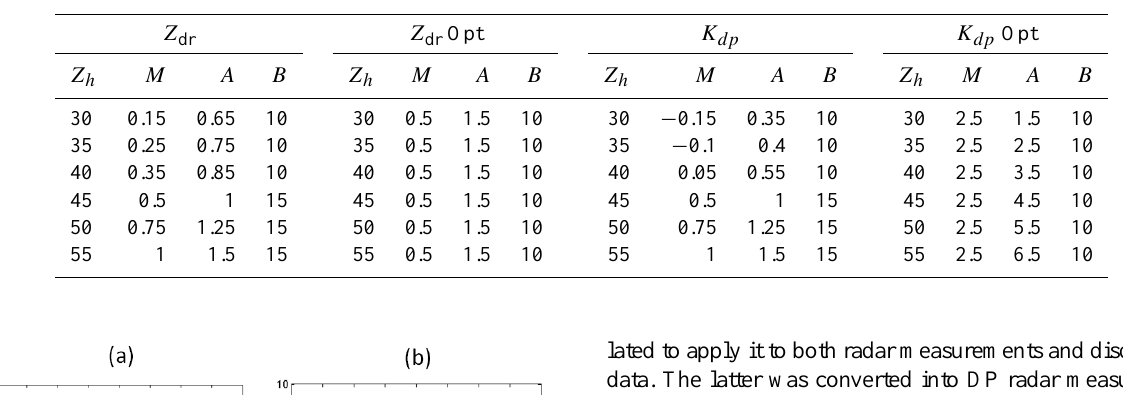
Table 2. Parameters of beta Z h − Z dr and Z h − K dp membership functions (Liu and Chandrasekar, 2000) for C-band and graupel identification ( A is half-width, M is the center, and B is the slope of the beta functions). Columns denoted by “Opt” refer to the functions of the modified HCA scheme optimized for graupel identification.